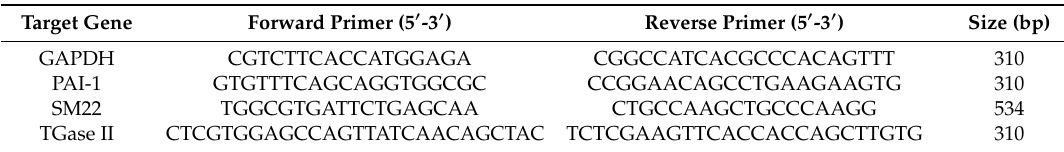
Table 1. Primer pairs used in the